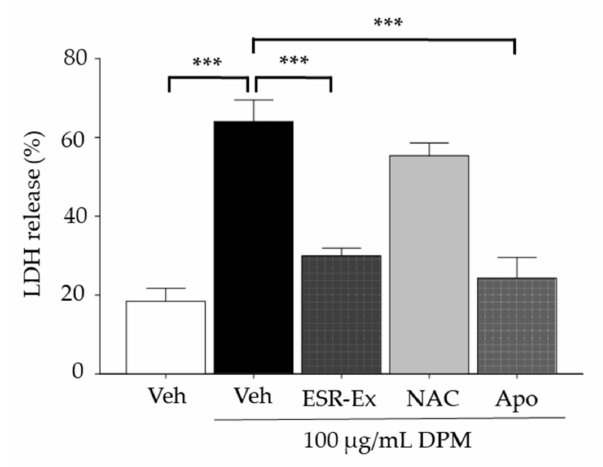
Figure 4. ESR-Ex decreases cell toxicity in KC treated with DPM. KC were incubated with or without ESR-Ex (100 µ g/mL), NAC (1 mM), Apo (100 µ M) or vehicle for 30 min, and then further cultured with 100 µ g/mL of DPM for 24 h. Cell toxicity was assessed by lactic dehydrogenase releasing assay. All values are mean ± SD ( n = 3). *** p < 0.001 vs. indicated group. See details in Materials and Methods Section.